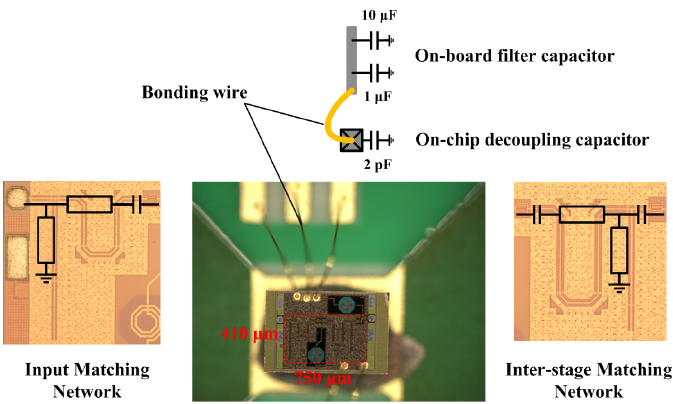
Figure 6. Chip microphotograph of the developed PA with on-chip decoupling capacitor and on-board filter capacitors.